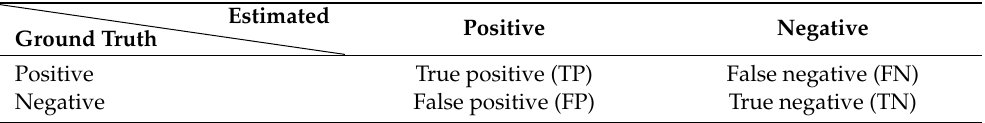
Table 2. Binary classification confusion